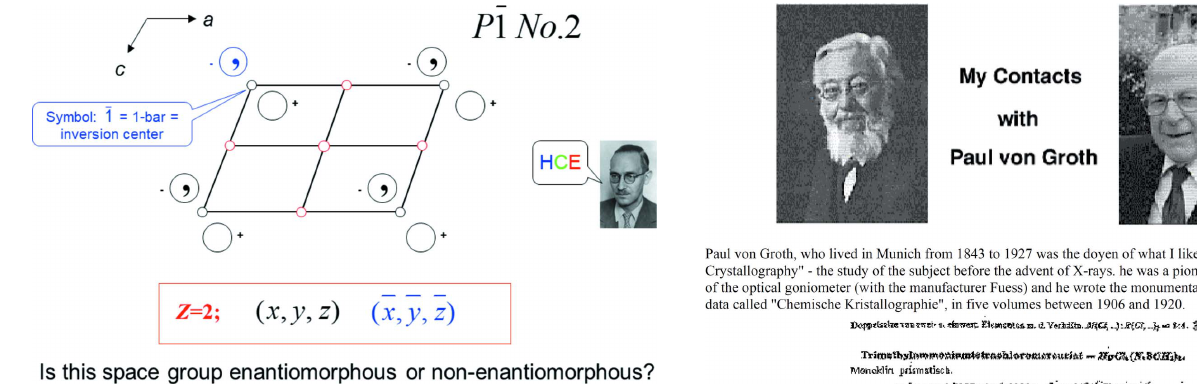
Figure 2 Slide 26, Chapter 1.